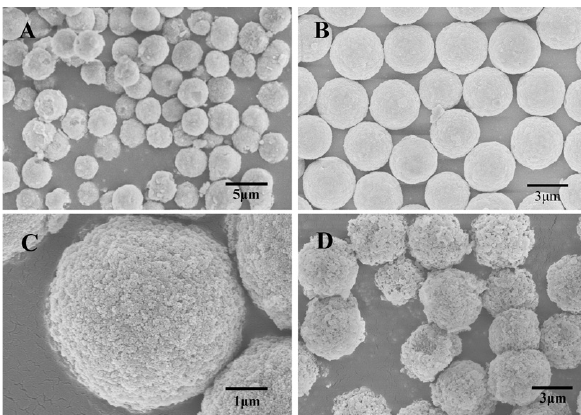
Figure 7: The SEM images of porous silica microspheres prepared at different molar ratio of formaldehyde and urea, (A) 1; (B) 1.25; (C) 1.5; (D)